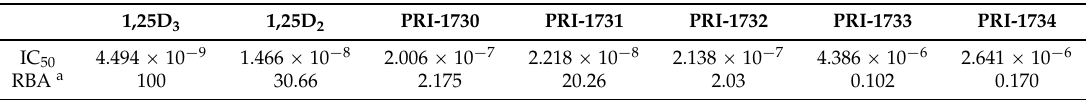
Table 1. The vitamin D receptor (VDR) binding affinity expressed as IC 50 and percentage activity.